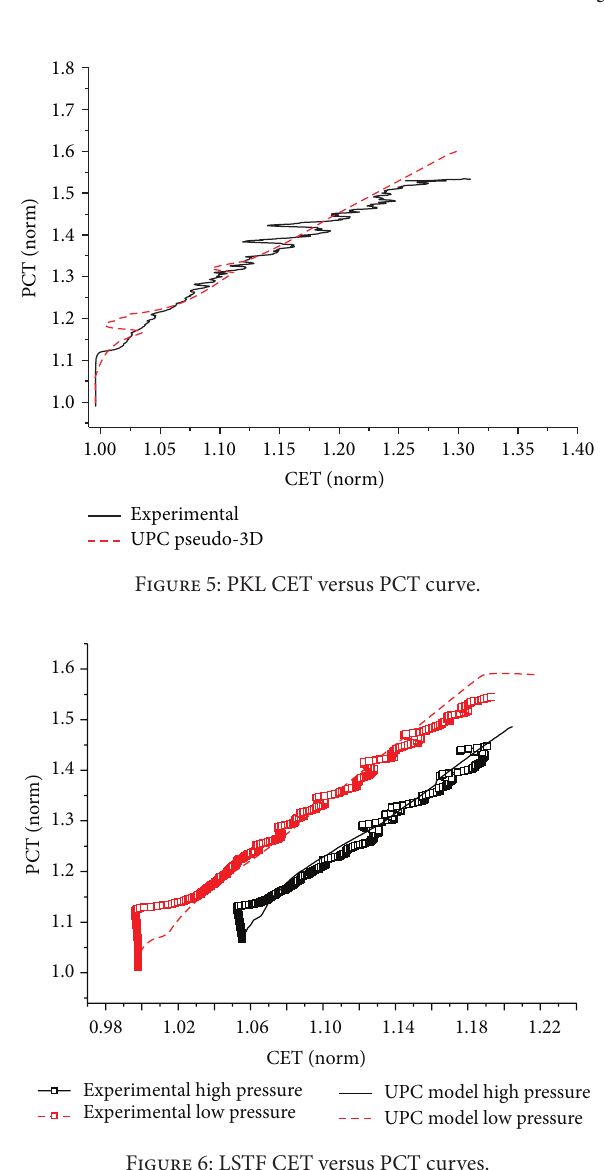
Figure 6: LSTF CET versus PCT